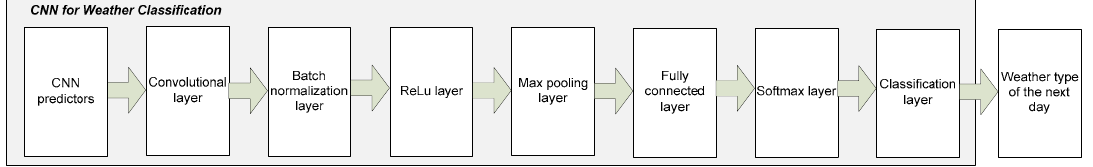
Figure 5. CNN classification for finding a suitable weather type.